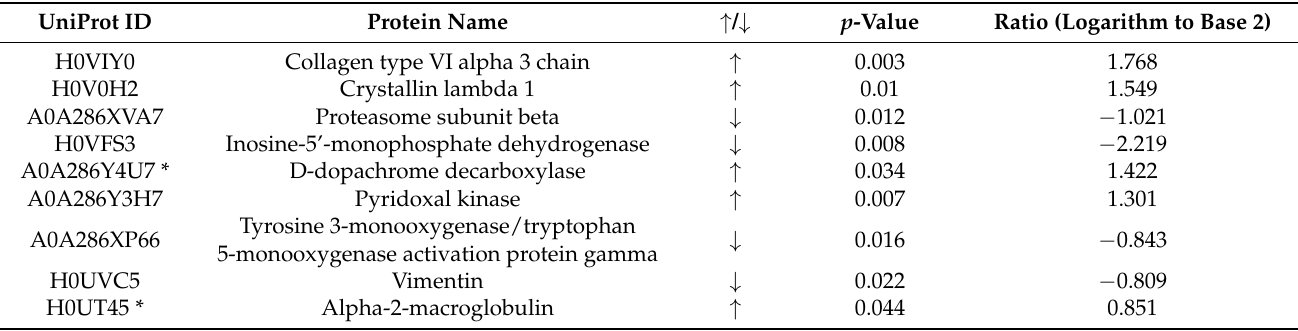
Table 2. Significant ( p < 0.05) increased ( ↑ )/decreased ( ↓ ) proteins in the contralateral ears of the animals implanted with IGF-1 in comparison to the contralateral ears of the ones implanted with AP. UniProt IDs marked with * were linked to an uncharacterized protein and the identification of the name was done using Basic Local Alignment Search Tool